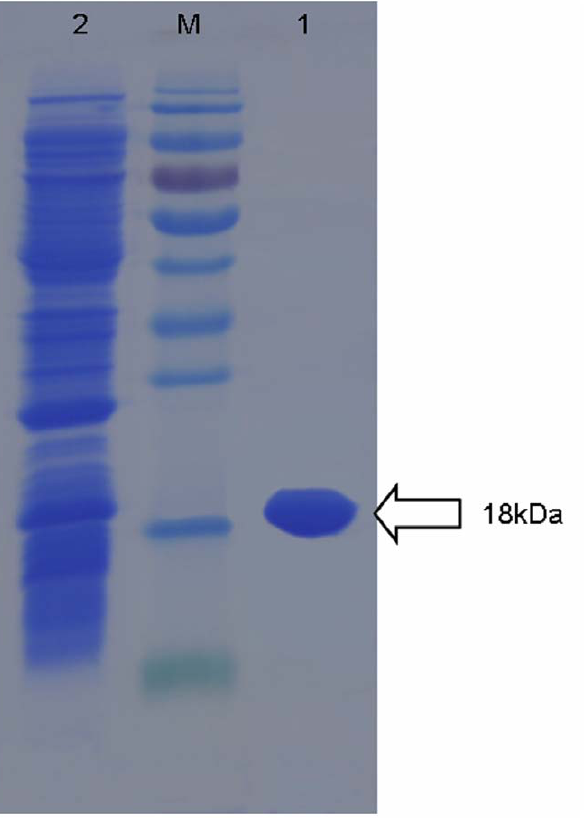
Figure 3. Purification of recombinant MoHrip1. M : protein molecular weight marker, 1 : Purified His-tagged MoHrip1, 2 : Total E. coli expressed proteins.